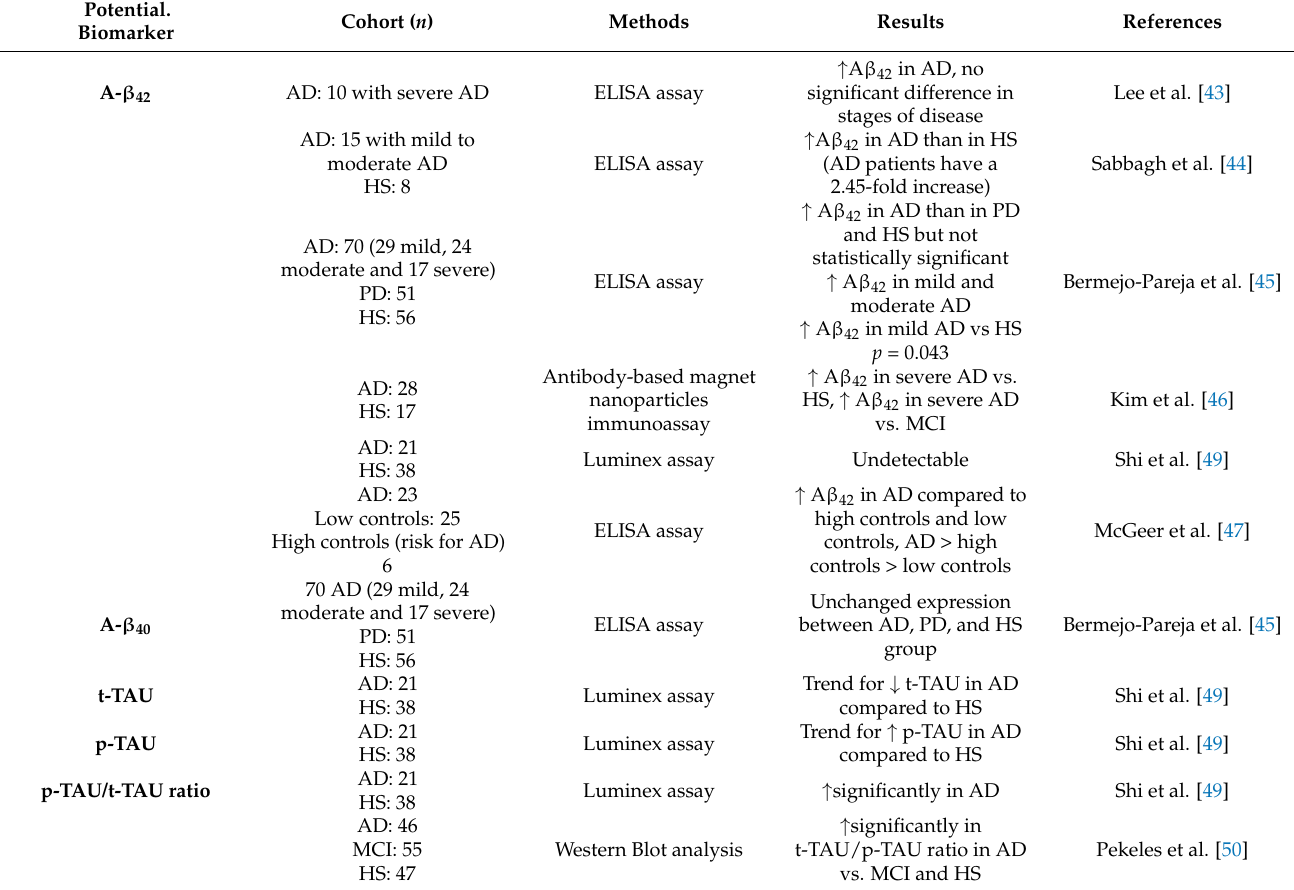
Table 3. Potential salivary biomarkers associated with Alzheimer’s disease (AD) described in clinical studies. Potential. Cohort ( n ) Methods Biomarker